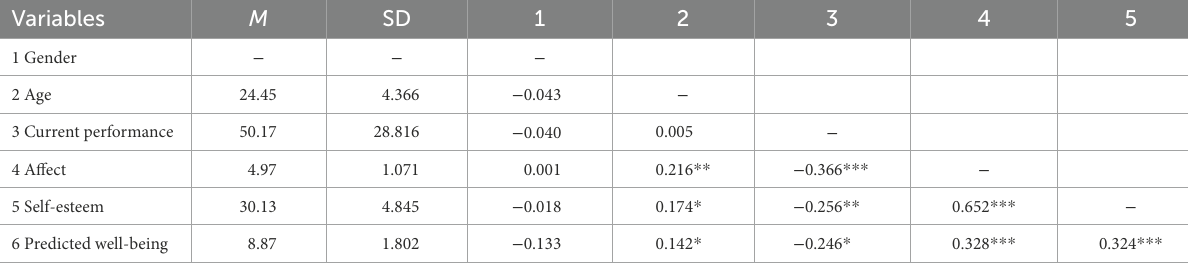
TABLE 2 Means, standard deviations and correlations of variables in high self-threat situation ( N = 209).